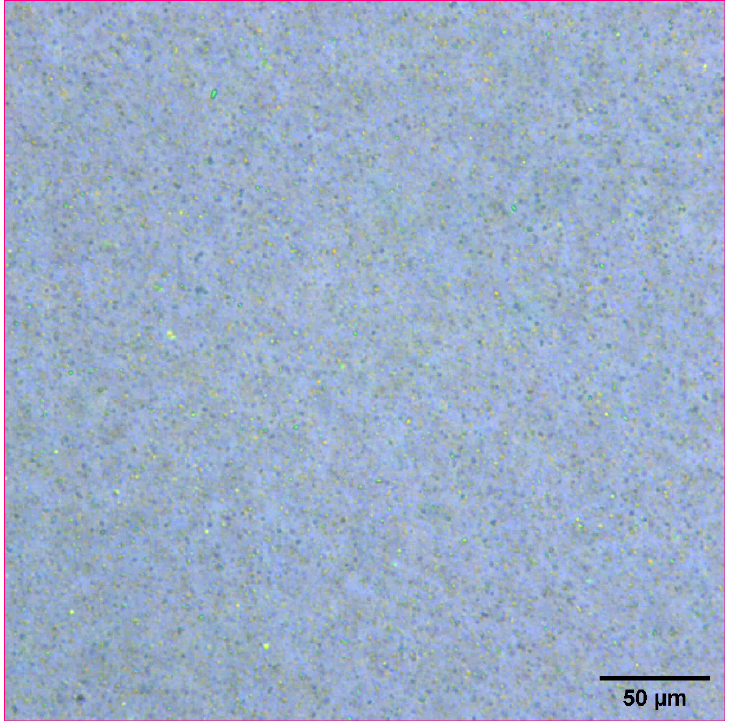
Figure 2. Optical microscope image of naproxen nanosuspension at a concentration of 100 mg/mL.